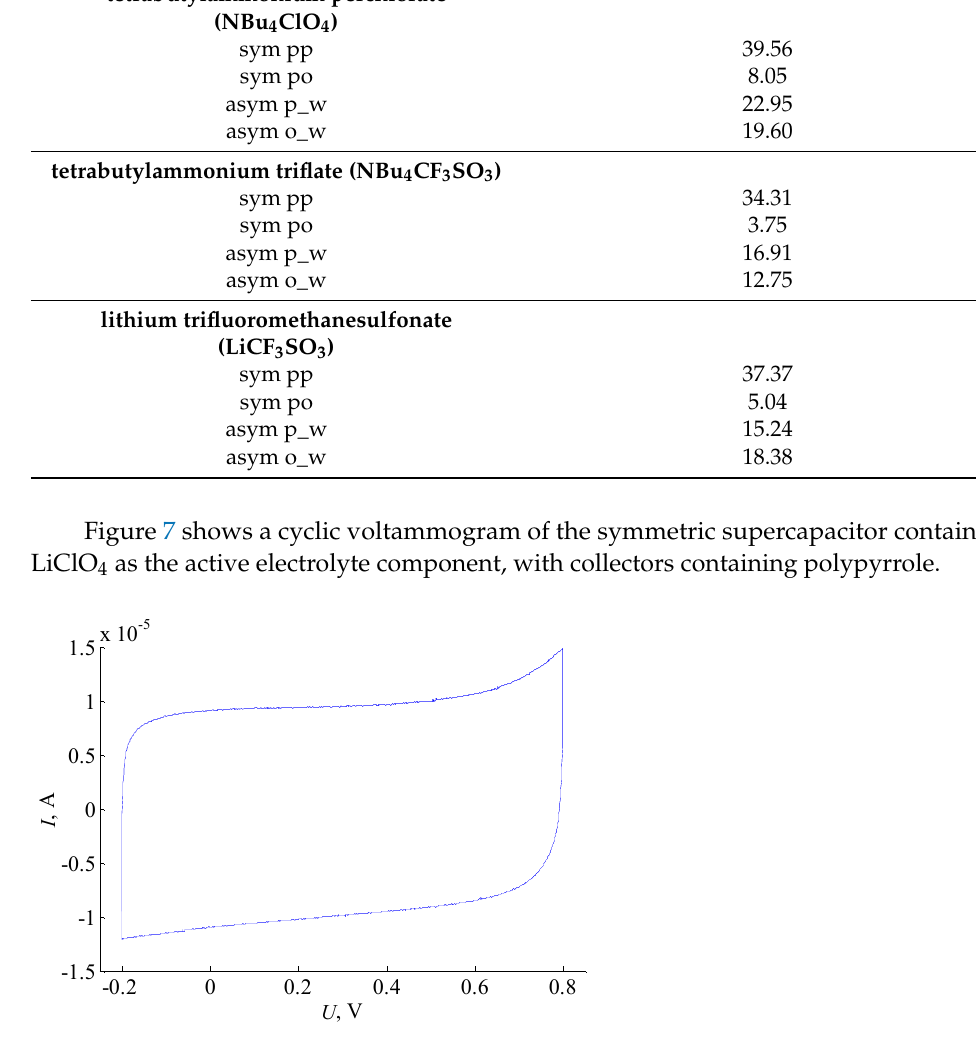
Figure 7. Cyclic voltammogram of the symmetric supercapacitor containing LiClO 4 as the active electrolyte component, with collectors containing polypyrrole.